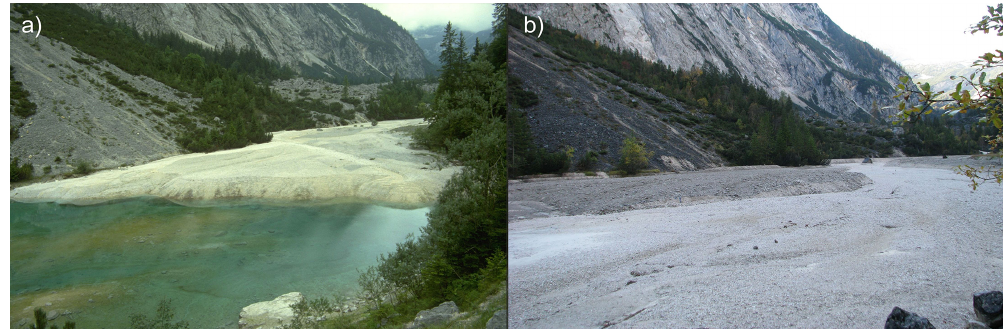
Figure 3. View of the second alluvial plain: (a) an ephemeral mountain lake created by a natural rockfall dam; (b) the same area filled with sediment after a high precipitation event in